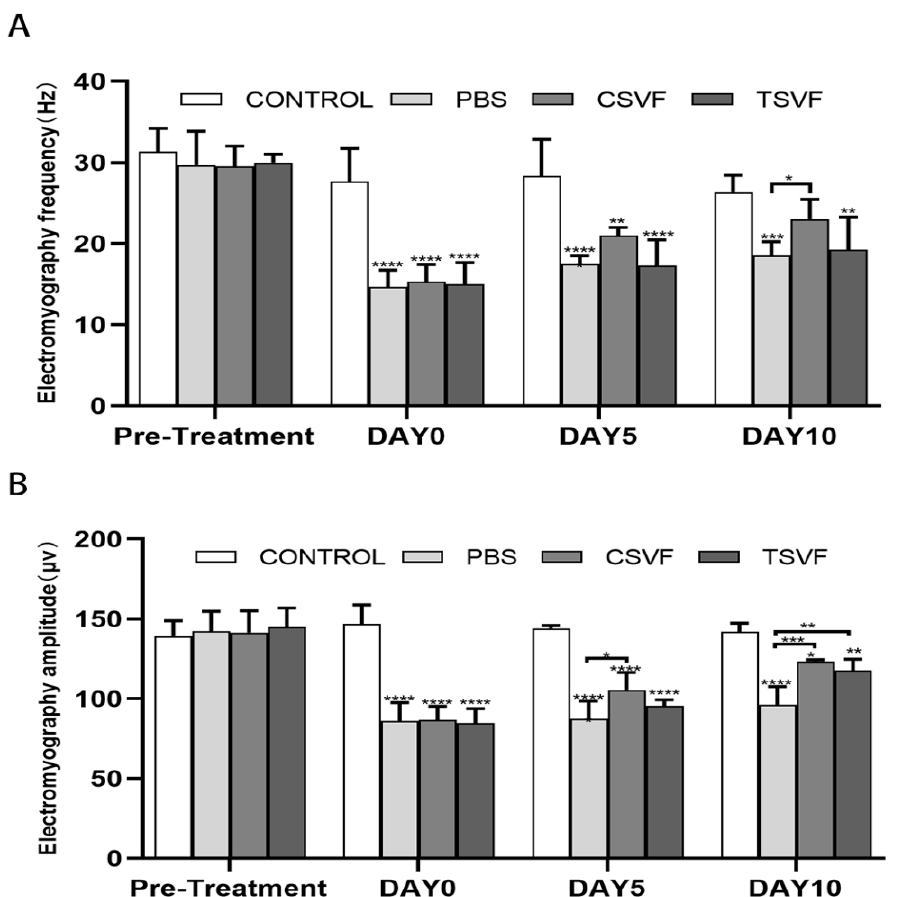
Figure 4. Statistical plots of EMG frequencies ( A ) and peaks ( B ) in the control group, the PBS group, the cSVF group, and the tSVF group before modeling and at 0, 5, and 10 days after cell treatment. All data was expressed as mean ± standard deviation. ‘*’, ‘**’, ‘***’, ‘****’ are represented as statistically different as p < 0.05, p < 0.01, p < 0.001, p < 0.0001, respectively. Those with horizontal lines represent statistical differences from the ends of the horizontal lines, and those without horizontal lines represent statistically differences compared to the control group.